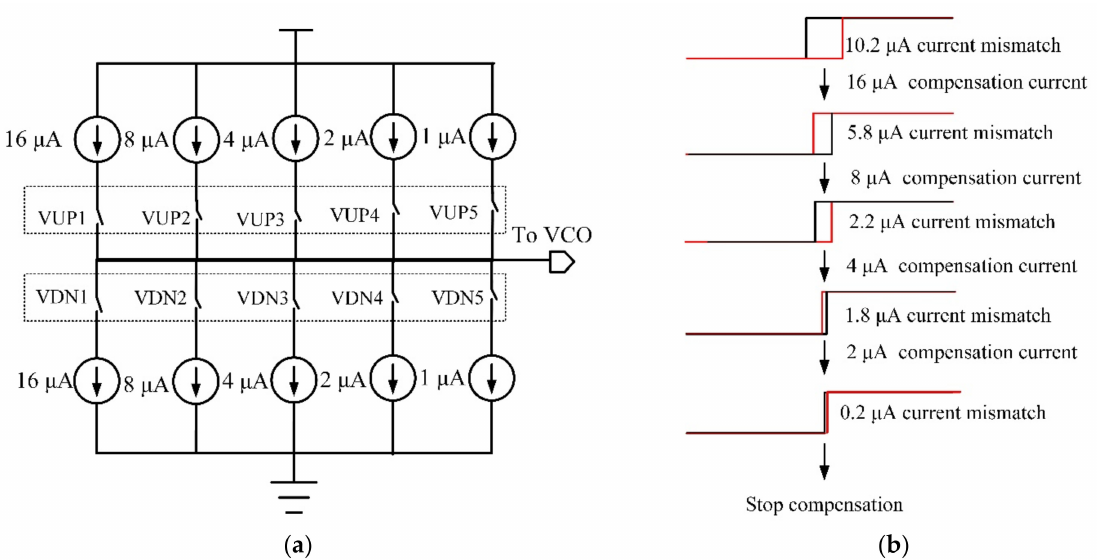
Figure 7. Examples of current mismatch compensation ( a ) compensation current source array; ( b ) the process of current compensation and the phase error